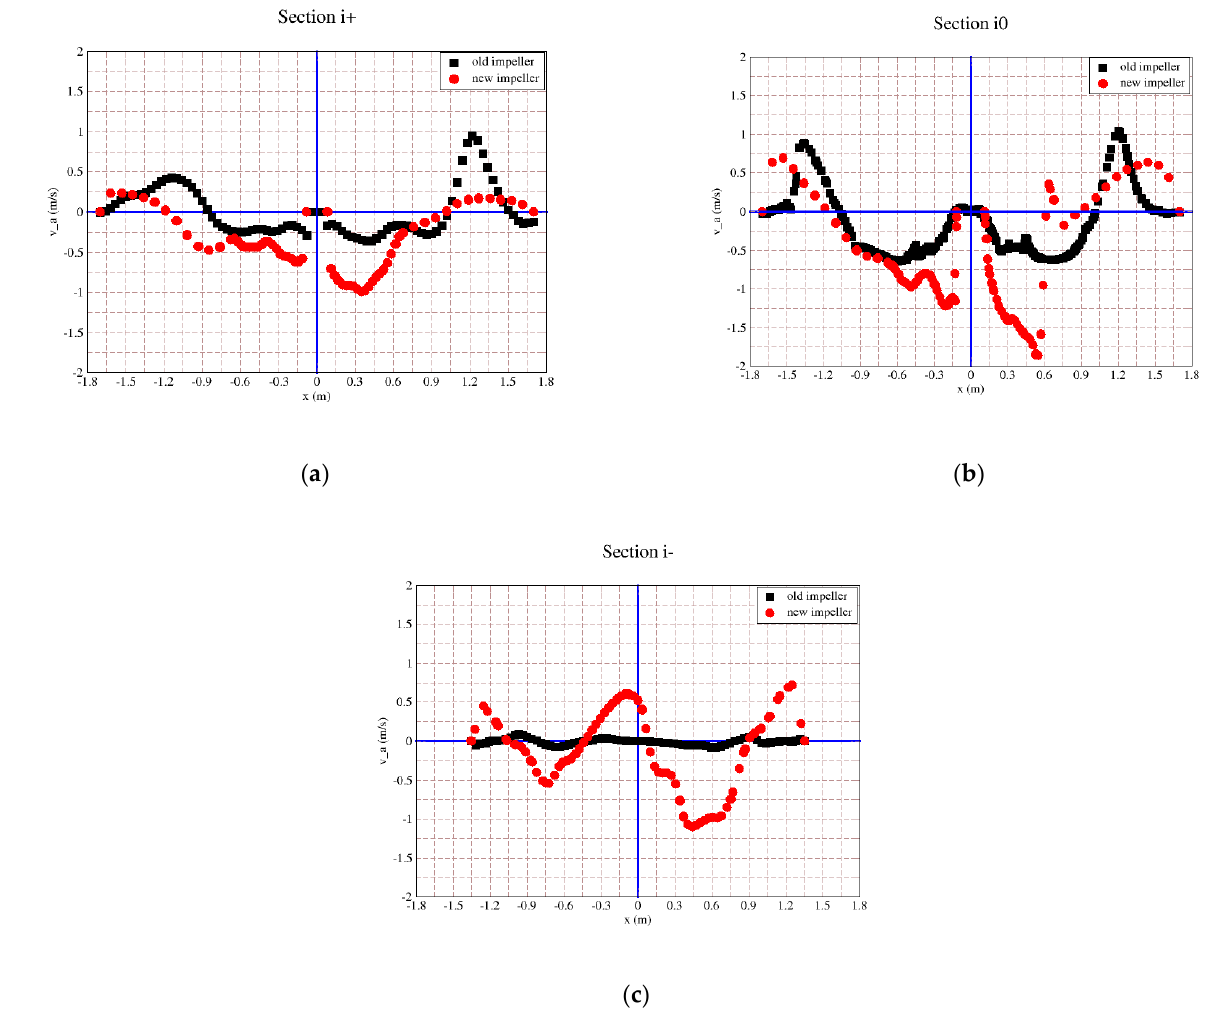
Figure 6. Axial velocity distribution of liquid phase at various axial levels, old impeller vs. new impeller: ( a ) above impeller; ( b ) impeller level; ( c ) under impeller.